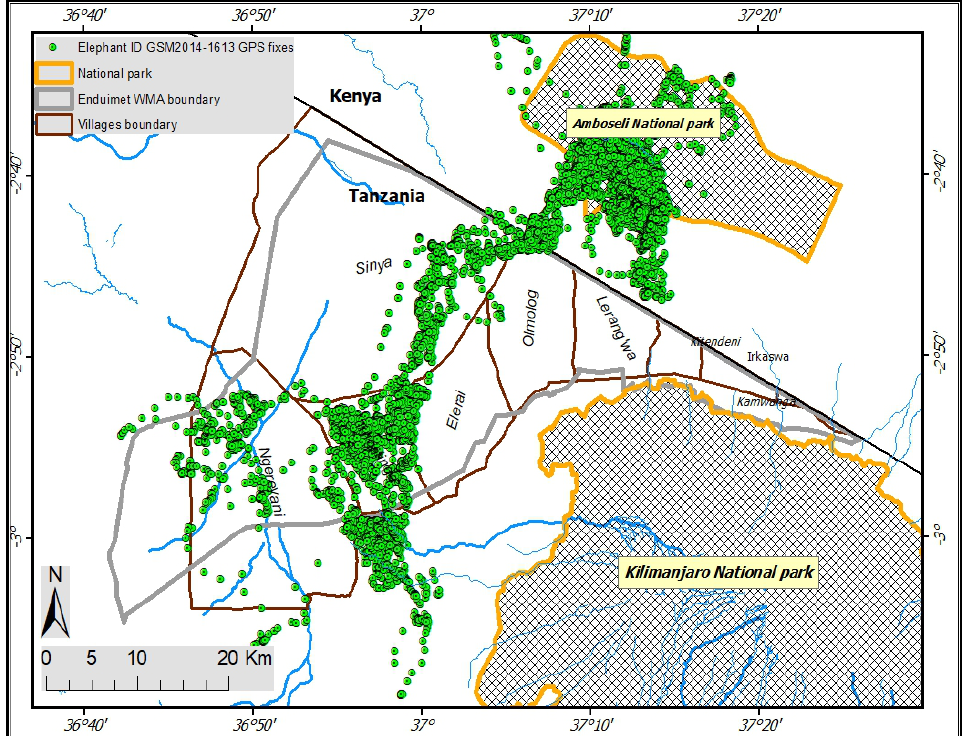
Figure A2. Spatial distribution of one collared elephant with the ID GSM2014-1613 ( n = 17,472) in